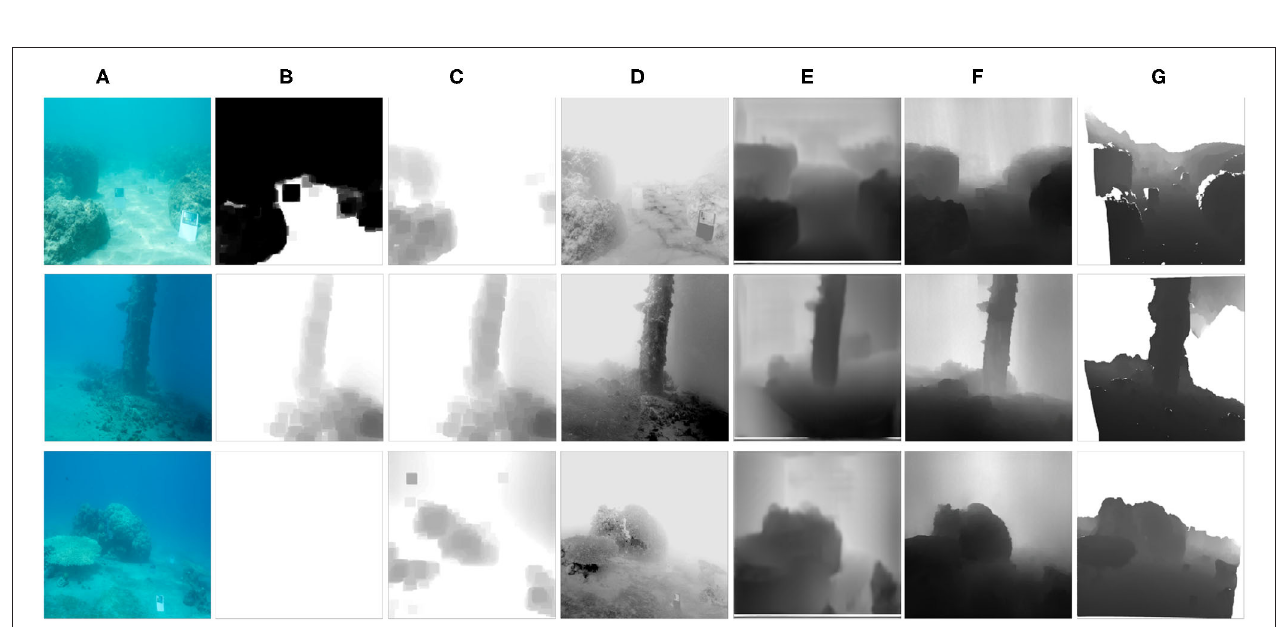
FIGURE 3 | Comparison of the visual quality of synthesized underwater images obtained by different methods. From left to right, (A) are original in-air images, (B–G) are the results of the WaterGAN (Li et al., 2017), CycleGAN (Zhu et al., 2017a), StarGAN (Choi et al., 2018), UW-Net (Gupta and Mitra, 2019), StarGAN v2 (Choi et al., 2020 ), and our method.